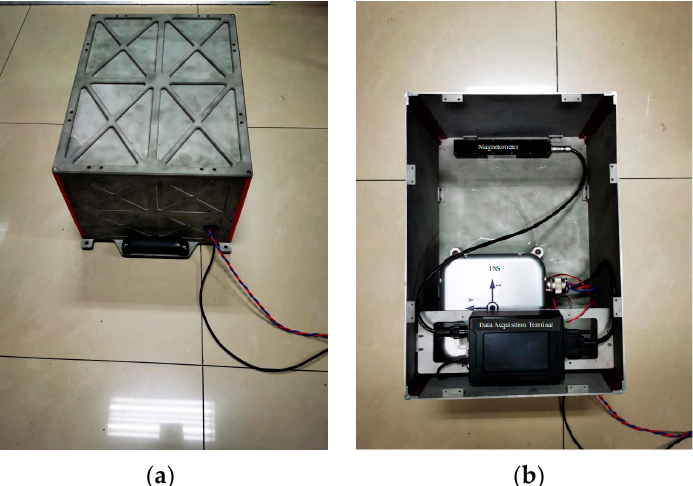
Figure 16. Strap-down geomagnetic dynamic measurement system: ( a ) overall system appearance;